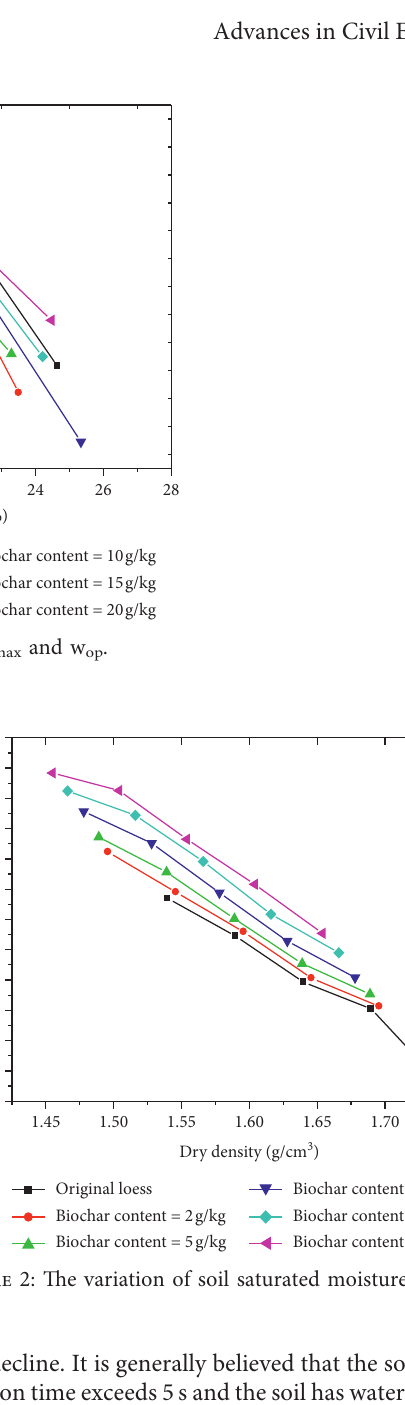
Figure 2: The variation of soil saturated moisture content.